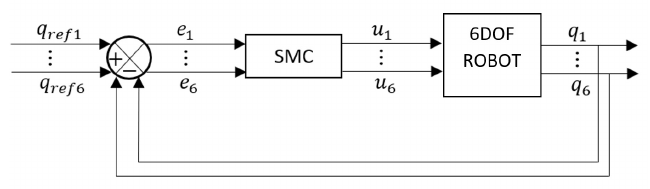
Figure 11. The control